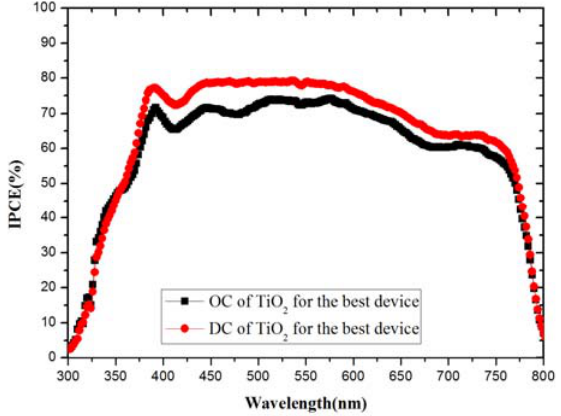
Figure 3. The external quantum efficiency (EQE) spectrum of best device from 300 to 800 nm. The black curve is device obtained by OC TiO 2 and red curve is device obtained by DC TiO 2 .